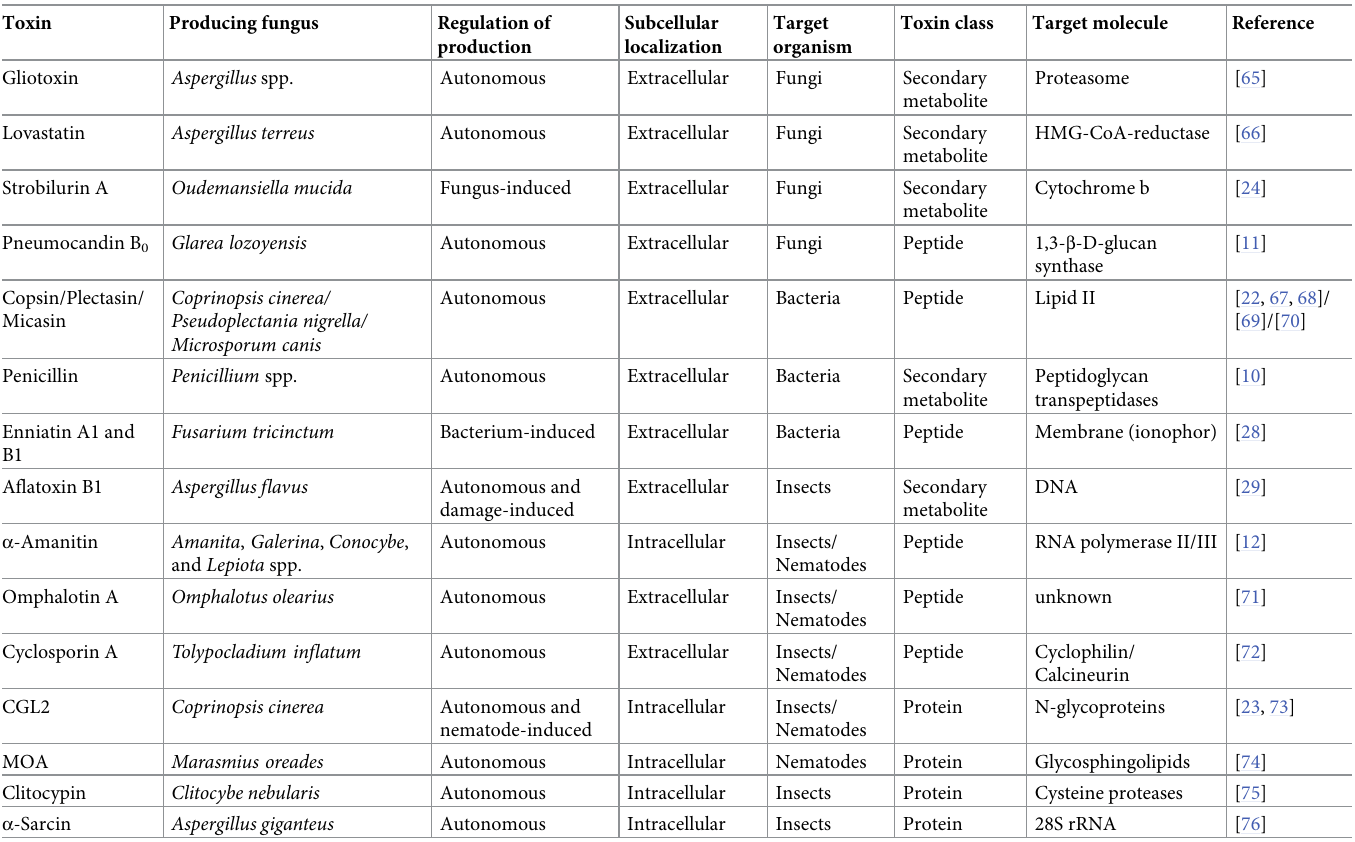
Table 1. Examples of fungal toxins and their